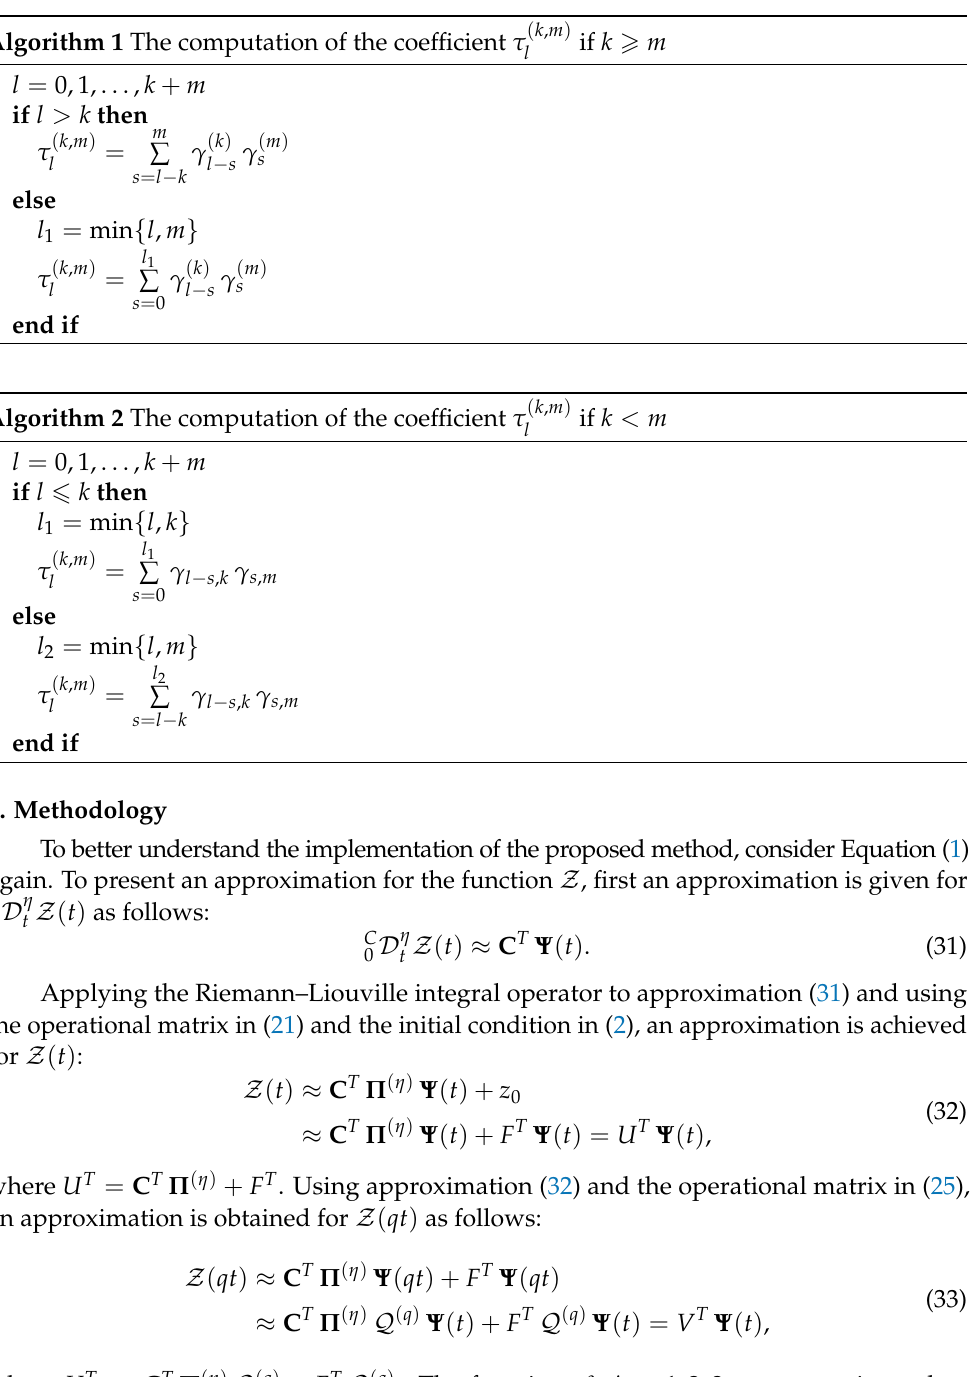
Algorithm 1 The computation of the coefficient τ